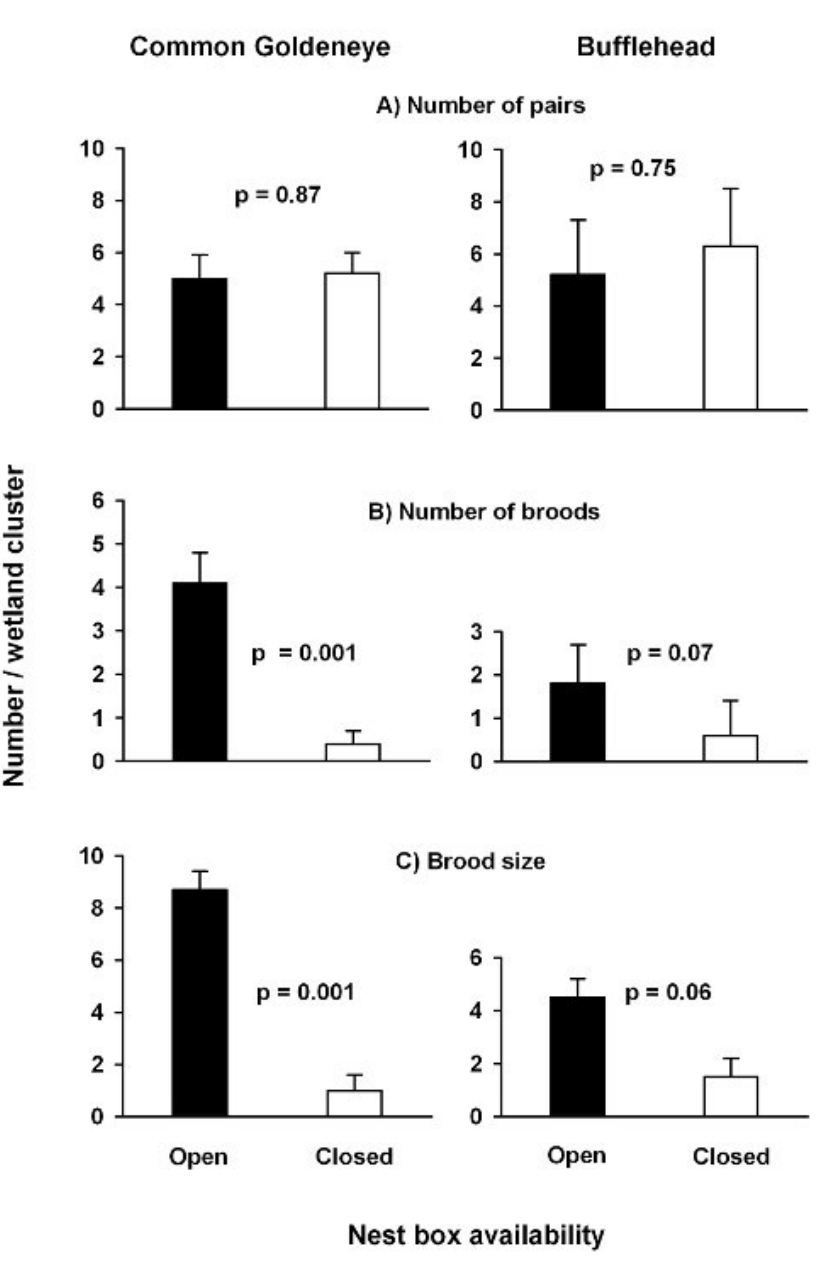
Fig. 4. Comparison of mean (± SE) number of pairs (A), broods (B), and brood size (C) of Common Goldeneye ( Bucephala clangula ) and Bufflehead ( Bucephala albeola ) in 2004 from clusters of wetlands where nest boxes were open (black fill) or closed (white) to occupancy in the Buffalo Lake Moraine, 2004. P-values reflect outcomes of t-tests for the effects of the nest box closure